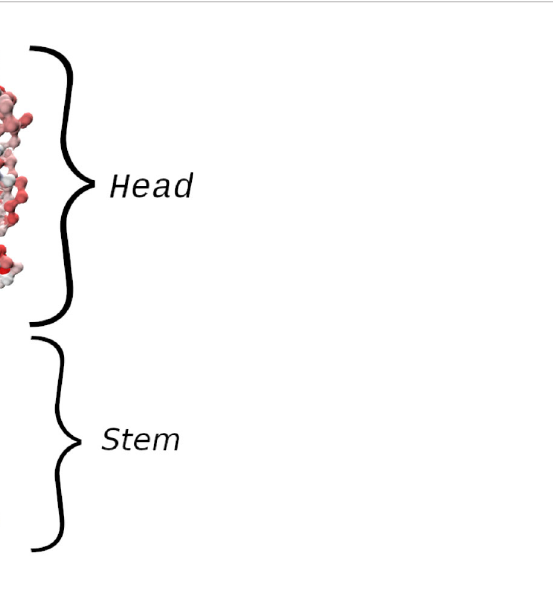
FIGURE 1 | In fl uenza hemagglutinin (HA) spike protein colored by residue conservation. Sequences of avian, swine and human in fl uenza type A spike proteins spanning the years 1918 – 2019 and subtypes 1-18 were downloaded from the NIH in fl uenza research database (3); conservation was computed in MATLAB (4) after clustering the sequences to 97% identity and multiple alignment. The HA structure was taken from PDB entry 3LZG (5), and the image was generated using Visual Molecular Dynamics (6). Only the C a atoms are